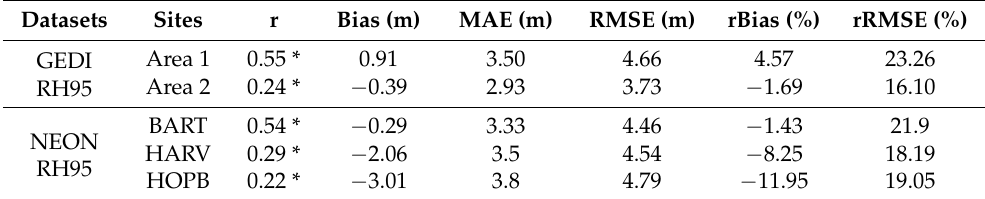
Table 5. Accuracy of RF-CH over the two study areas and three NEON sites compared with high- quality GEDI RH95 and NEON RH95, respectively. The asterisk represents a significant correlation ( p <